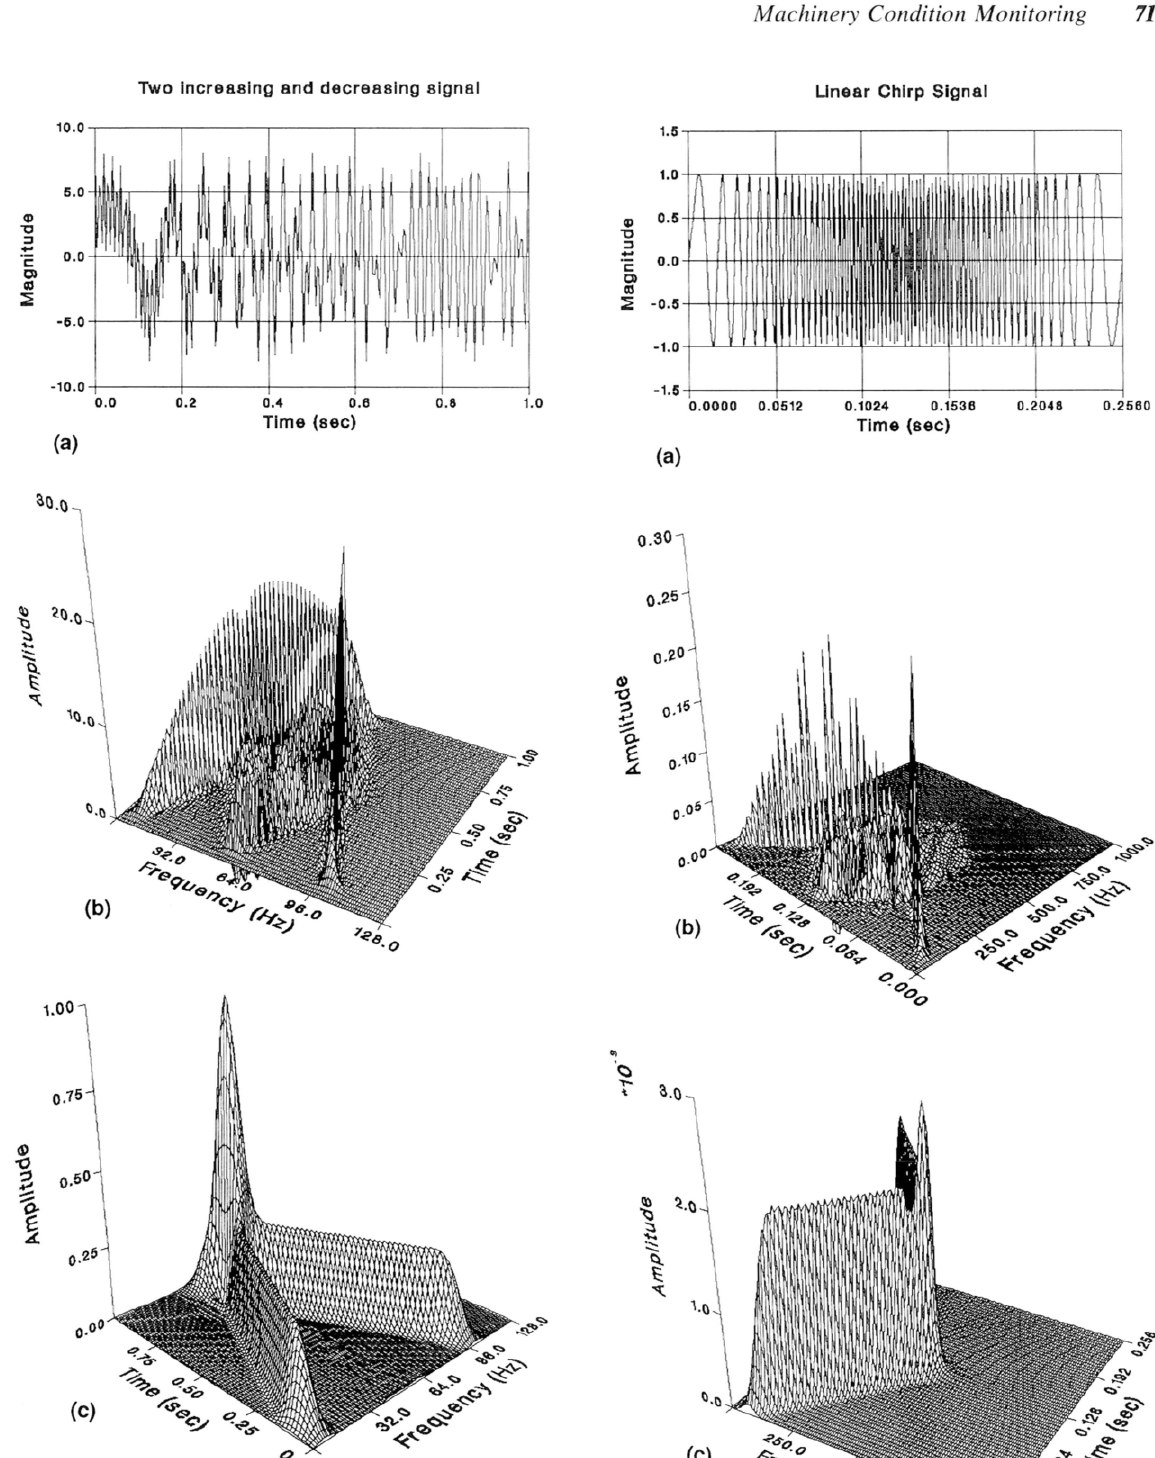
FIGURE 5 Composite signal with two frequency components at each time. (a) Time signal, (b) WDF, and (c) PWVD. Is = 256 Hz, N = 256, and smoothing window size = 10 x 10. set) = 4cos(21T32t 2) + 4cos{21T[40 + 32(2 - t)]t }